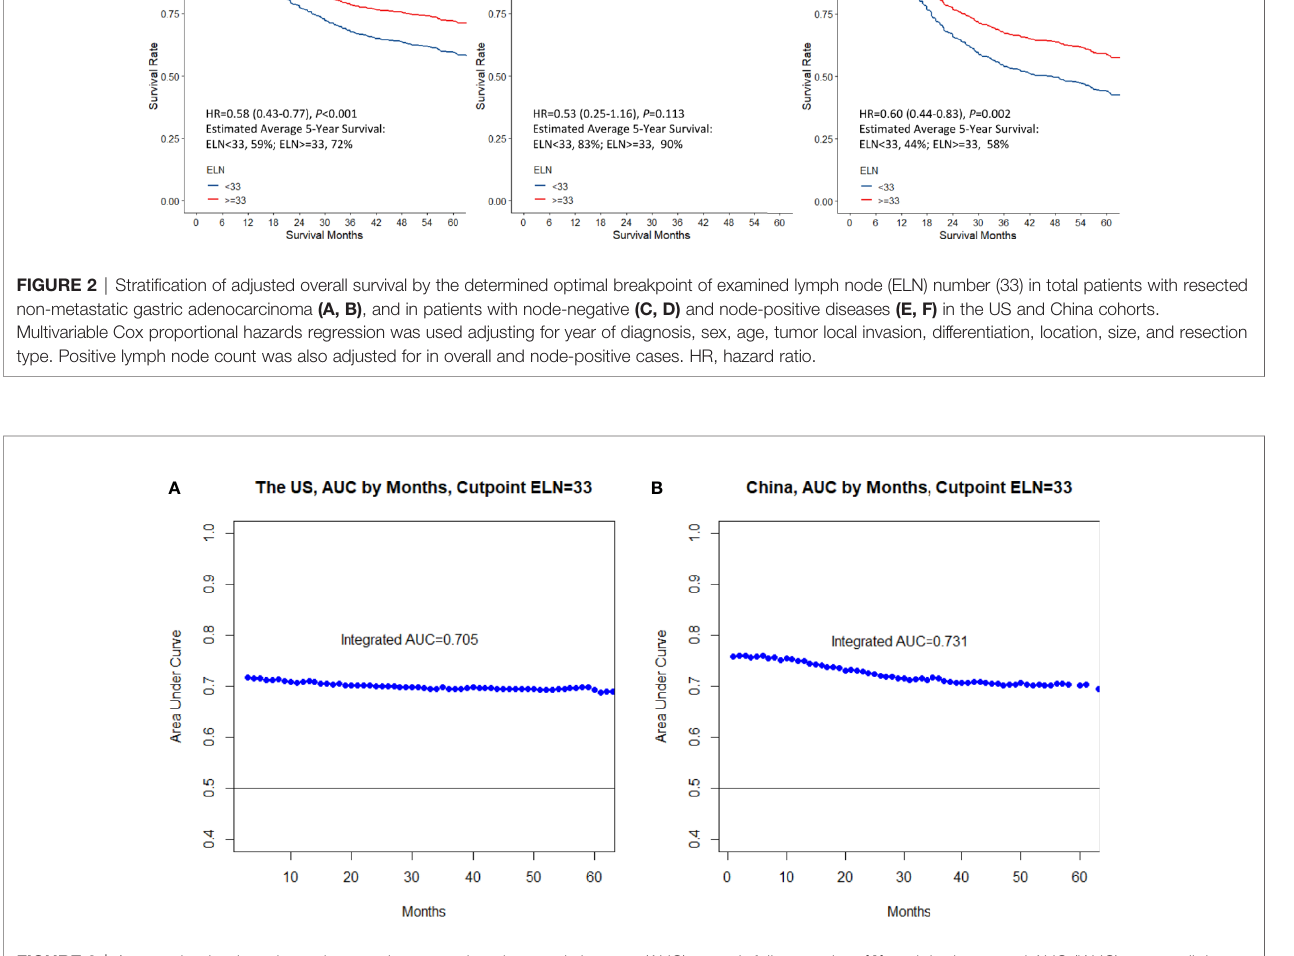
FIGURE 3 | Area under the time-dependent receiver operating characteristic curve (AUC) at each follow-up time (A) and the integrated AUC (iAUC) across all the follow-up period (B) assessing the accuracy of the multivariable-adjusted Cox proportional hazards regression model incorporating the optimal threshold (33)- dichotomized ELN number in survival